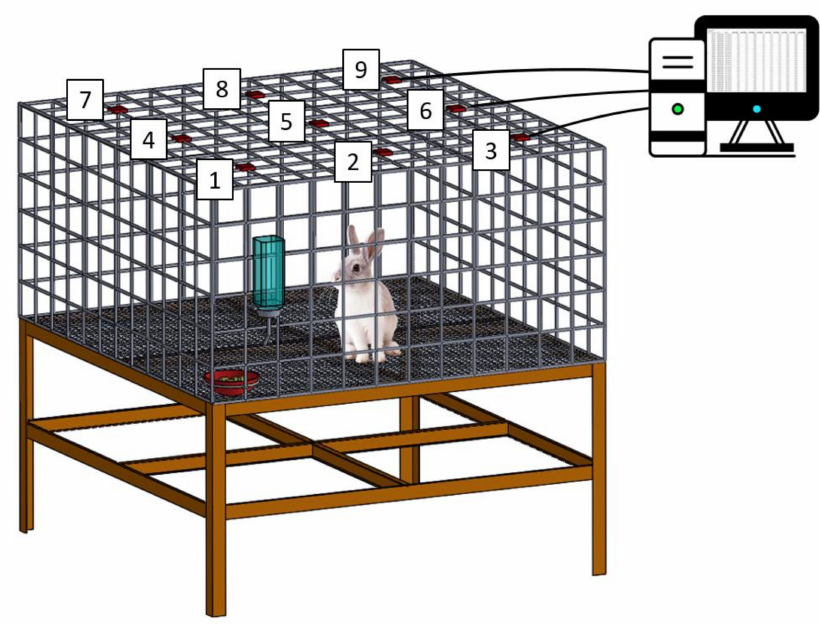
Figure 2. Schematic of the animal behavior cage. The cage (120 cm × 120 cm × 60 cm) was divided into nine symmetrical square areas. One diffusion-scan type photoelectric switch sensor was placed above each square